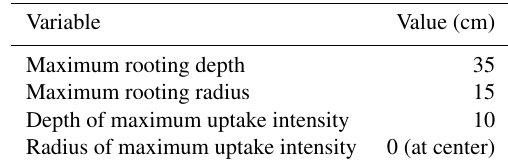
Table 1. Feddes root model parameters and values.